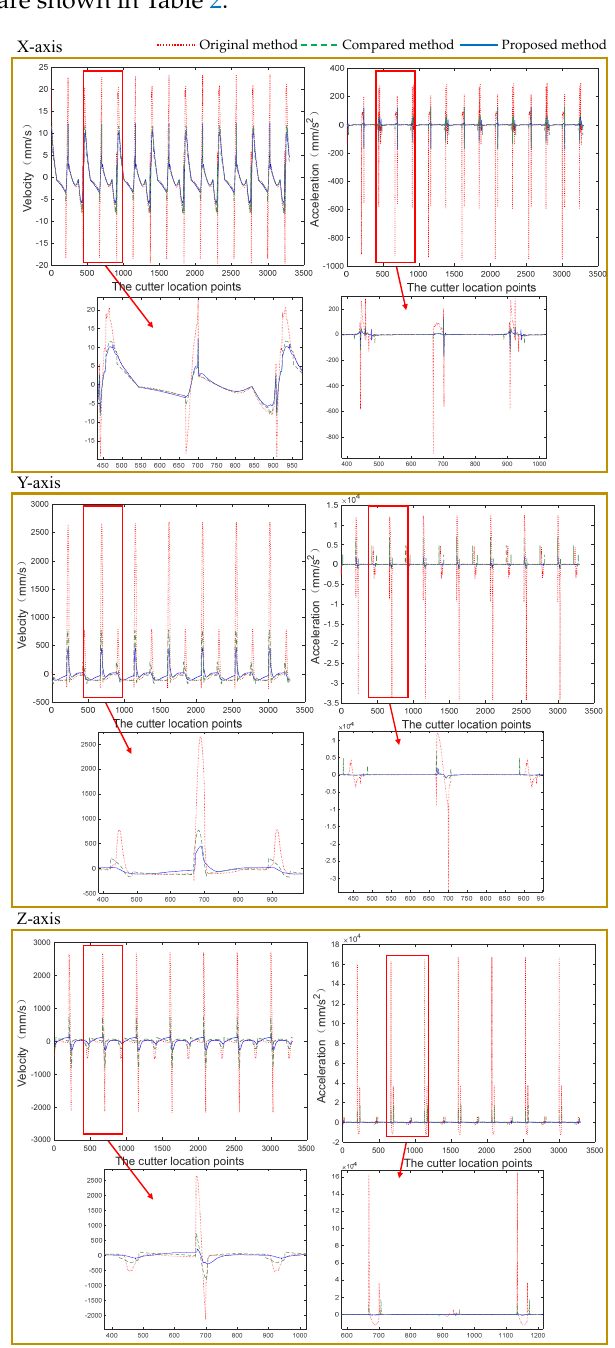
Figure 16. Comparison of motion state of the rotary axis.